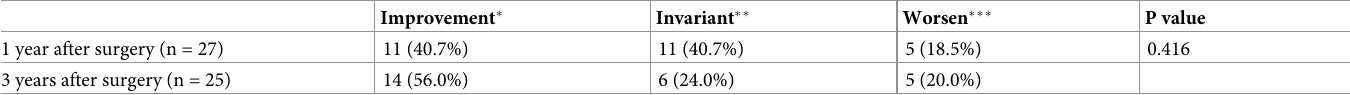
Table 2. Distributions of visual acuity improvement, invariance, and deterioration at 1 and 3 years after